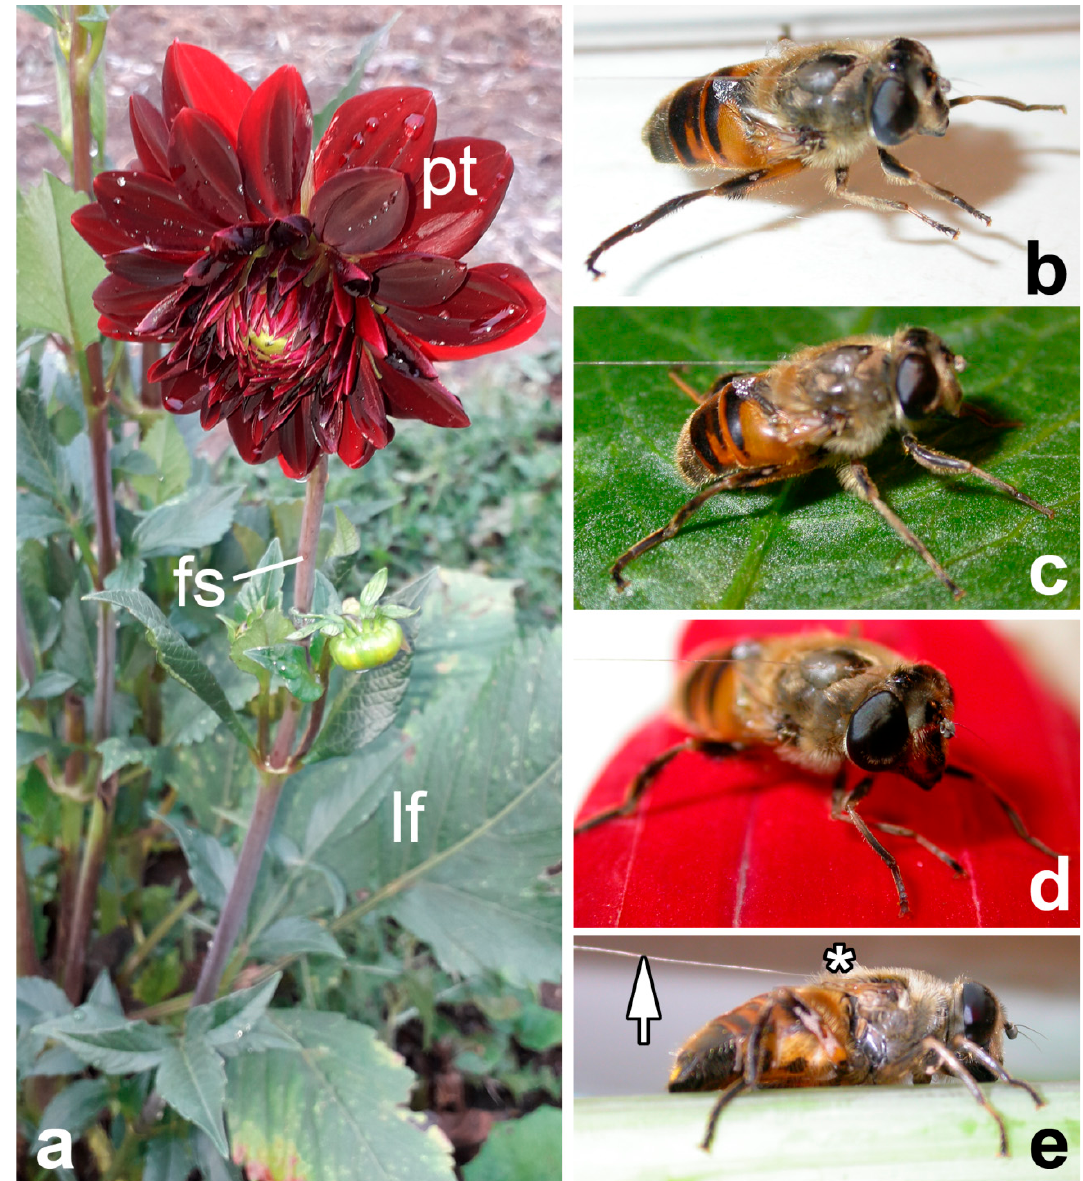
Figure 1. The plant Dahlia pinnata ( a ) and the fly Eristalis tenax in the experiments on different test substrates ( b – e ): glass ( b ), the adaxial (upper) side of the leaf ( c ), the adaxial side of the petal ( d ), and the stem ( e ). In ( e ), arrow points to a hair attached dorsally to the fly thorax using a droplet of molten beewax (asterisk). Abbreviations: fs, flower stem; lf, upper leaf; pt, petal (actually, ray flower).